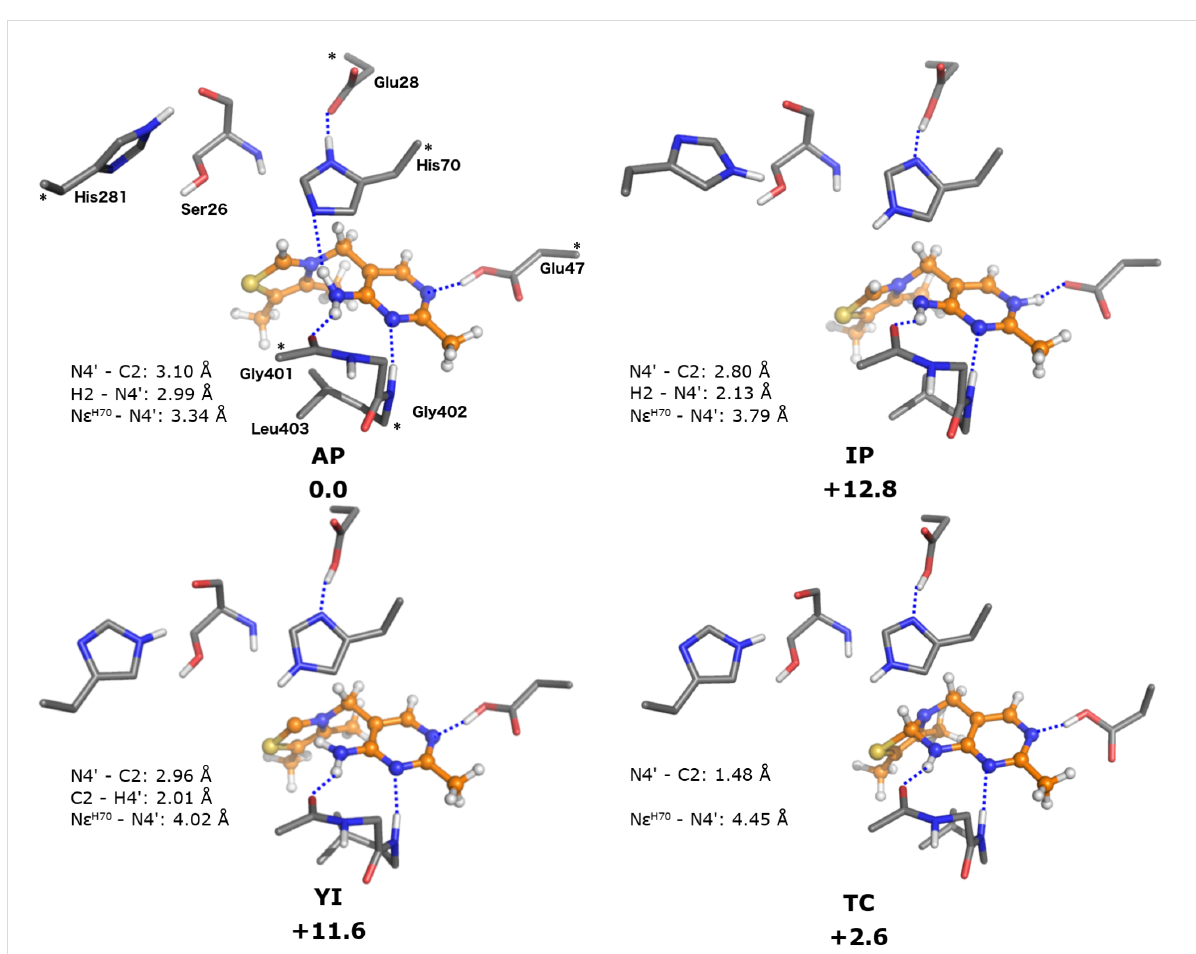
Figure 3: Optimized structures of the states of BFDC-bound ThDP in the absence of ligand (model B ). Relative energies are indicated in kcal/mol. For clarity, only a selected part of the model is shown, for full model, see Figure 1.